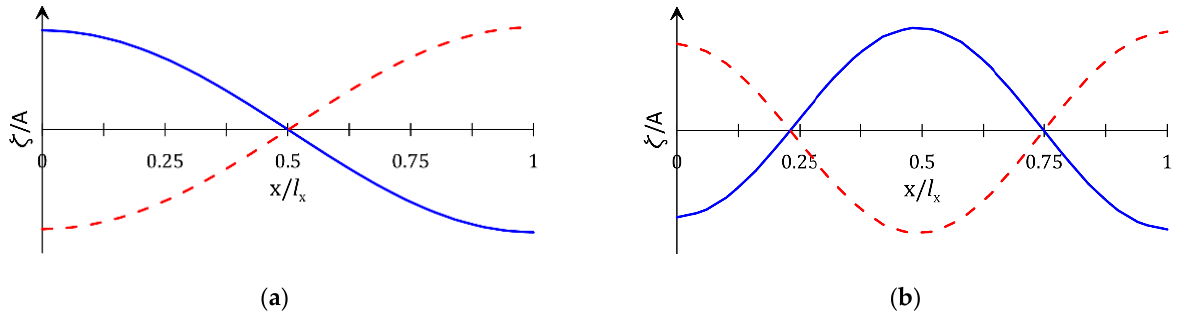
Figure 9. Longitudinal free-surface profiles of sloshing mode inside the OWC chamber: ( a ) first longitudinal sloshing mode, ω = 1.8 rad/s; ( b ) second longitudinal sloshing mode, ω = 2.5 rad/s; (solid line: crest, dashed line: trough).